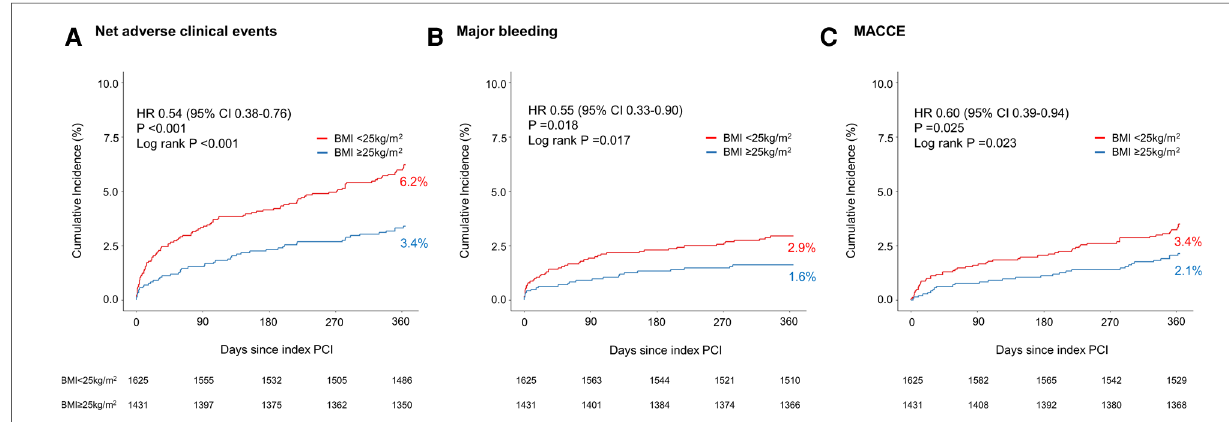
FIGURE 2 Kaplan – Meier curves for the clinical outcomes between pre-speci fi ed BMI subgroups of TICO population. ( A ) Net adverse clinical events, ( B ) major bleeding, and ( C ) major adverse cardiac and cerebrovascular events in patients with either BMI <25 or ≥ 25 kg/m 2 . BMI, body mass index; CI, con fi dence interval; HR, hazard ratio; MACCE, major adverse cardiac and cerebrovascular events; PCI, percutaneous coronary